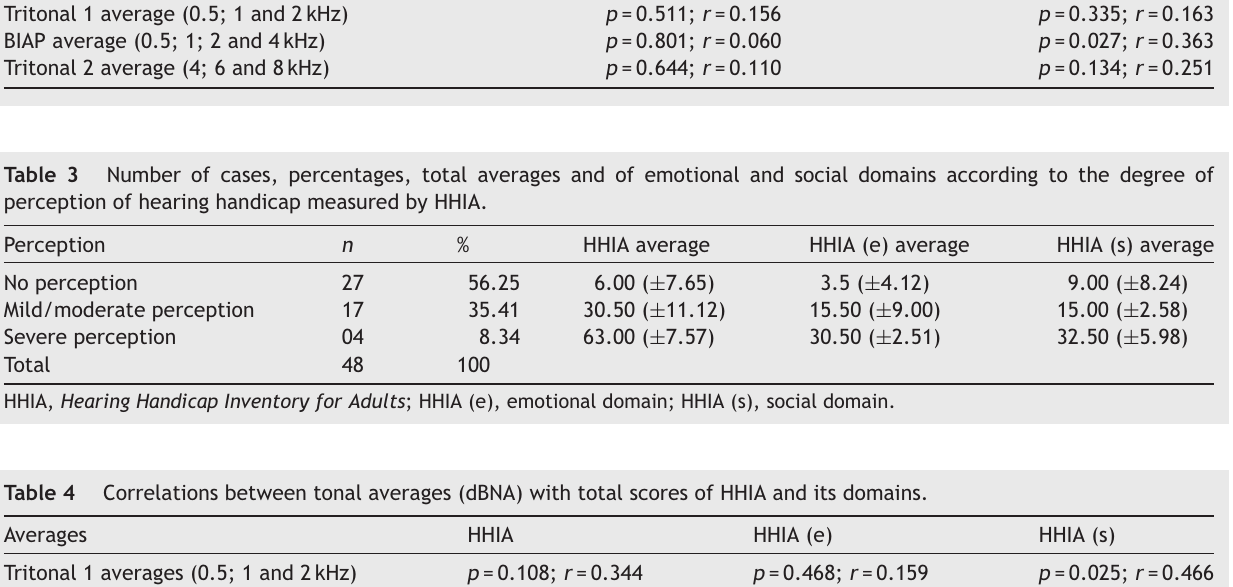
Correlations between the tonal averages and the time of hemodialysis of Groups I and II. Averages Group I Group II TH Tritonal 1 average (0.5; 1 and 2 kHz)